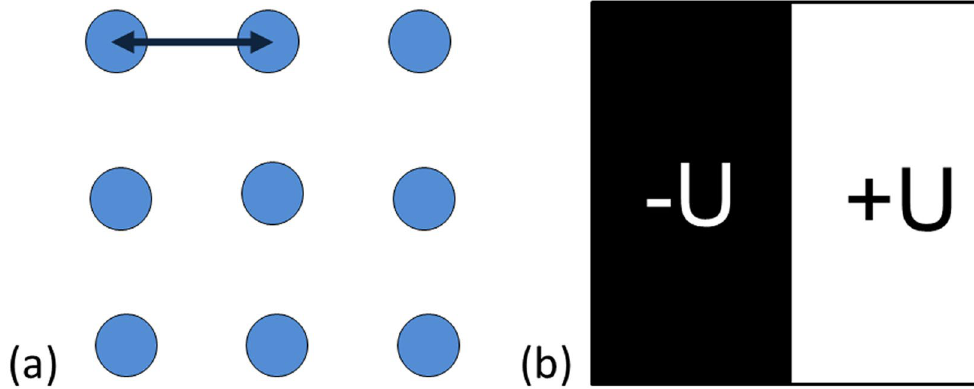
Figure 1. Schemes of creation of polarized states by ( a ) “discrete” and ( b ) “continuous”